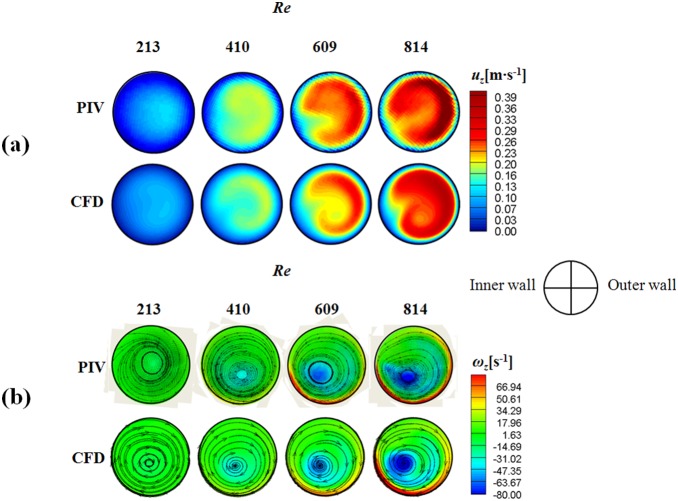
Comparison of PIV and CFD results data at the outlet of a helical tube (H/R0 = 8, Rc/R0 = 1.0).(a) Axial velocity distribution and (b) normal-direction vorticity contours and corresponding streamlines.